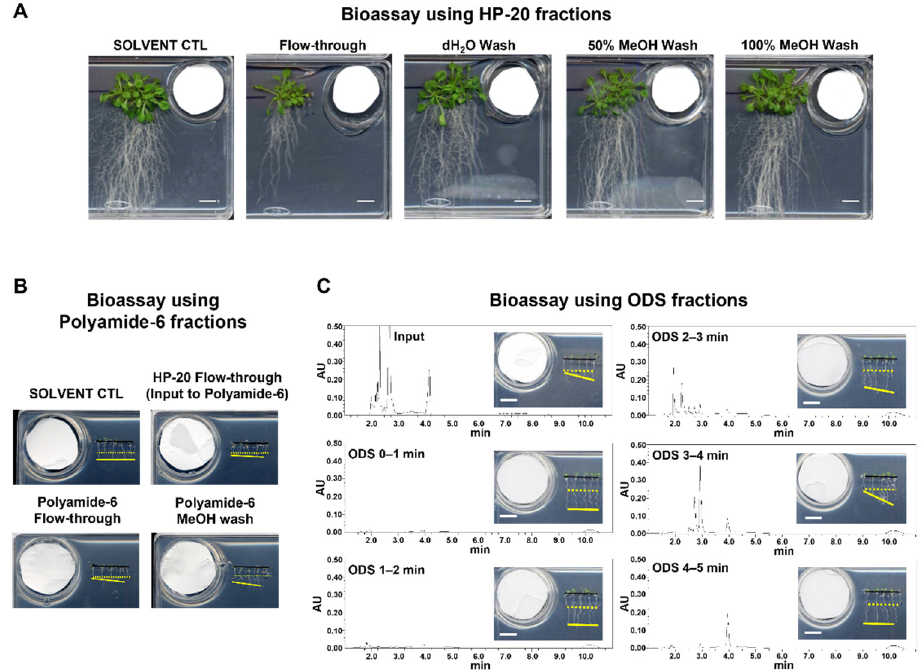
Figure A3. Bioassay-based purification of the compounds responsible for plant growth-inhibitory activity. All of the bioassays were conducted at 23 °C under long-day photoperiods. Solid and dashed yellow lines within inlets indicate the position of the root tips upon transplantation and after 2 days of incubation, respectively. White bars, 1 cm. ( A ) Bioassays using HP-20 fractions. Each fraction was spotted onto filter paper used in the bioassay with Arabidopsis seedlings. Photographs were taken after 3 weeks of incubation. White bars; 2 cm. ( B ) Bioassays using polyamide-6 fractions. The flow-through fraction from the HP-20 column was fractionated on a polyamide-6 column with increasing methanol concentration. For the bioassays, 10 µl out of 5 ml of each fraction was used. Photographs were taken after 2 days of incubation. ( C ) Bioassay testing fractions from ODS chromatography. Ultraviolet absorbance at 205 nm was monitored by a photodiode array detector.